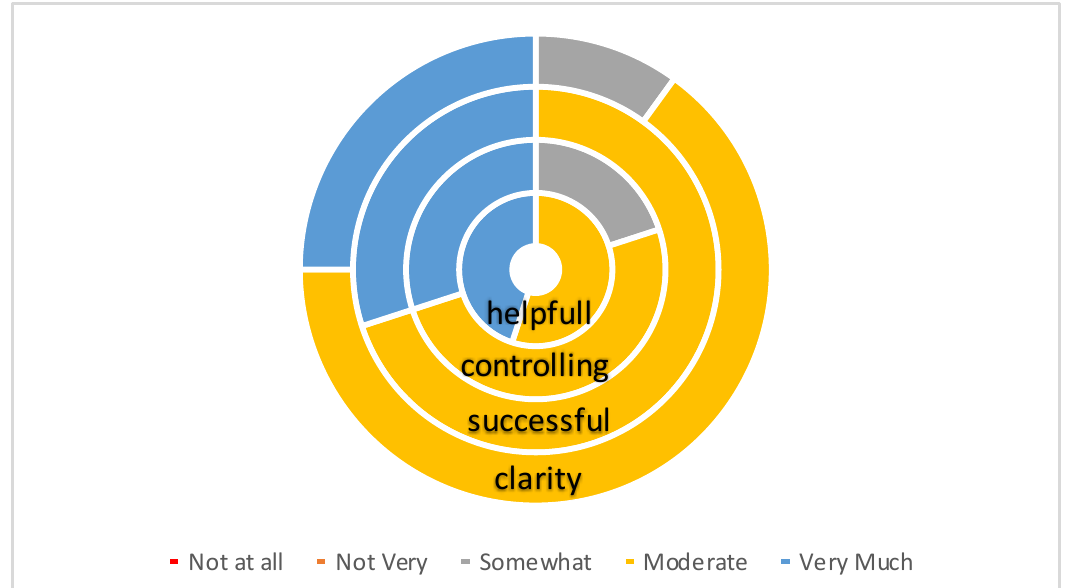
Figure 11. Effectiveness and performance of the app.